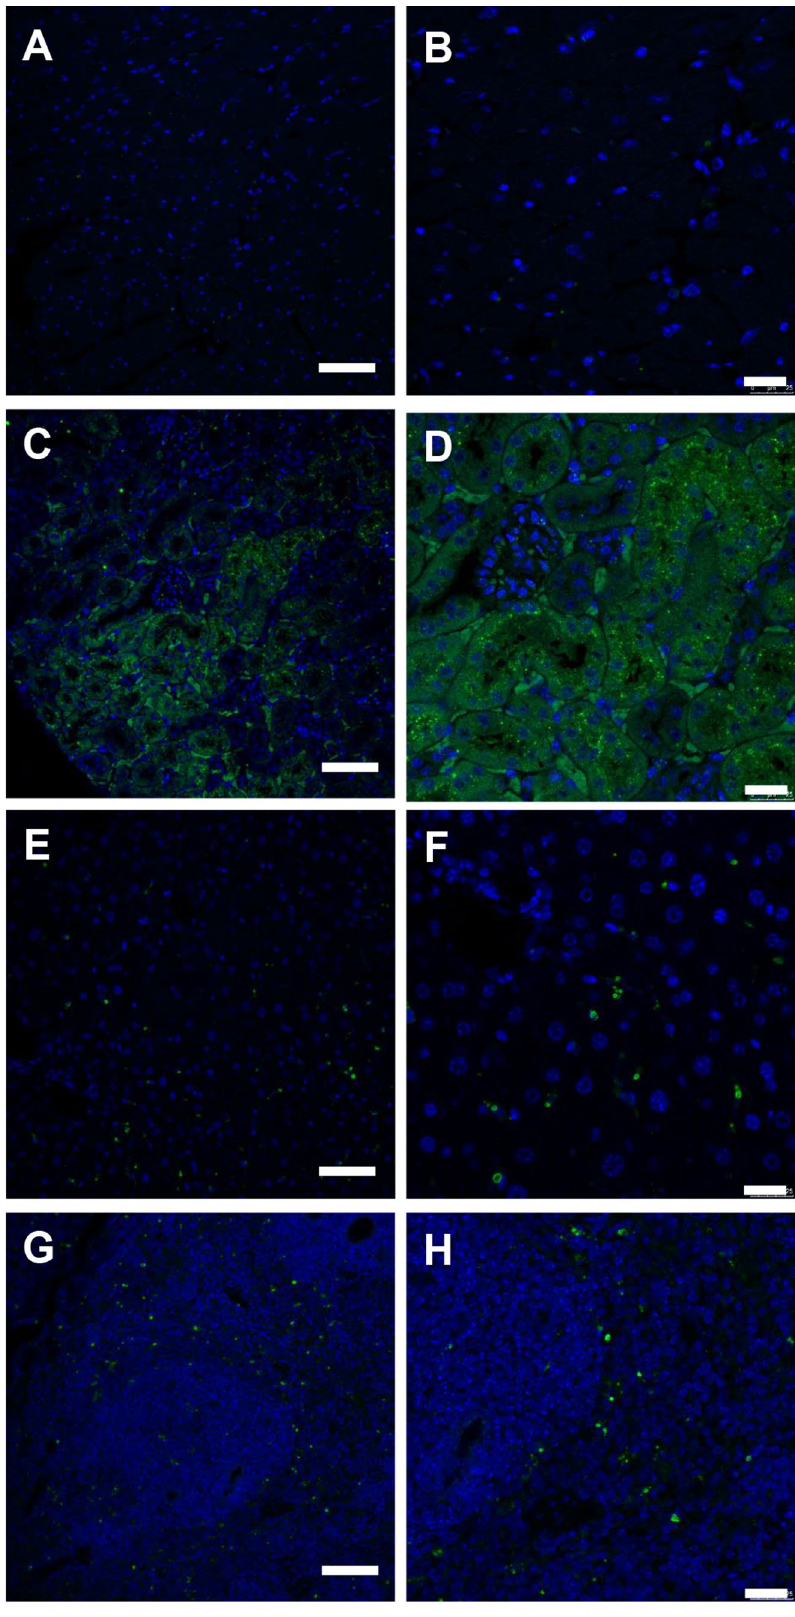
Figure 6. Immunofluorescence images of fCNC-AF488 in mouse (A,B) heart, (C,D) kidney, (E,F) liver and (G,H) spleen tissue. Anti-AF488 staining (green) 24 h after intravenous administration of fCNC-AF488. Tissue distribution of nanomaterial was not evidenced in heart tissue but accumulation was noted in kidney, liver and spleen. Scale bars are for Panels ( A,C,E,G) are 75 µm; scale bars are for Panels ( B,D,F,H) are 25 µm. Nuclei (blue) are